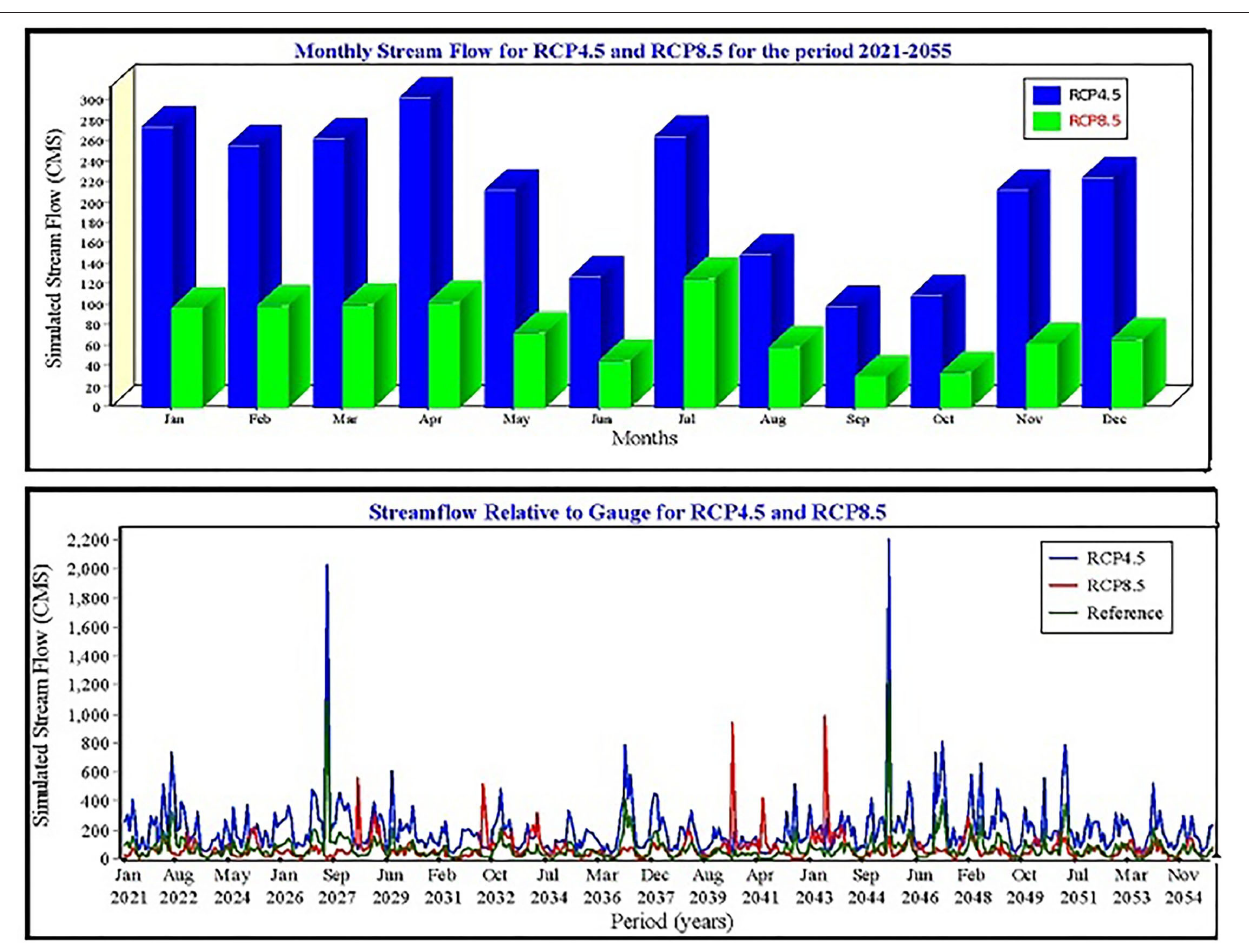
FIGURE 6 | Comparison of monthly and annual stream flow projection under RCP4.5 and